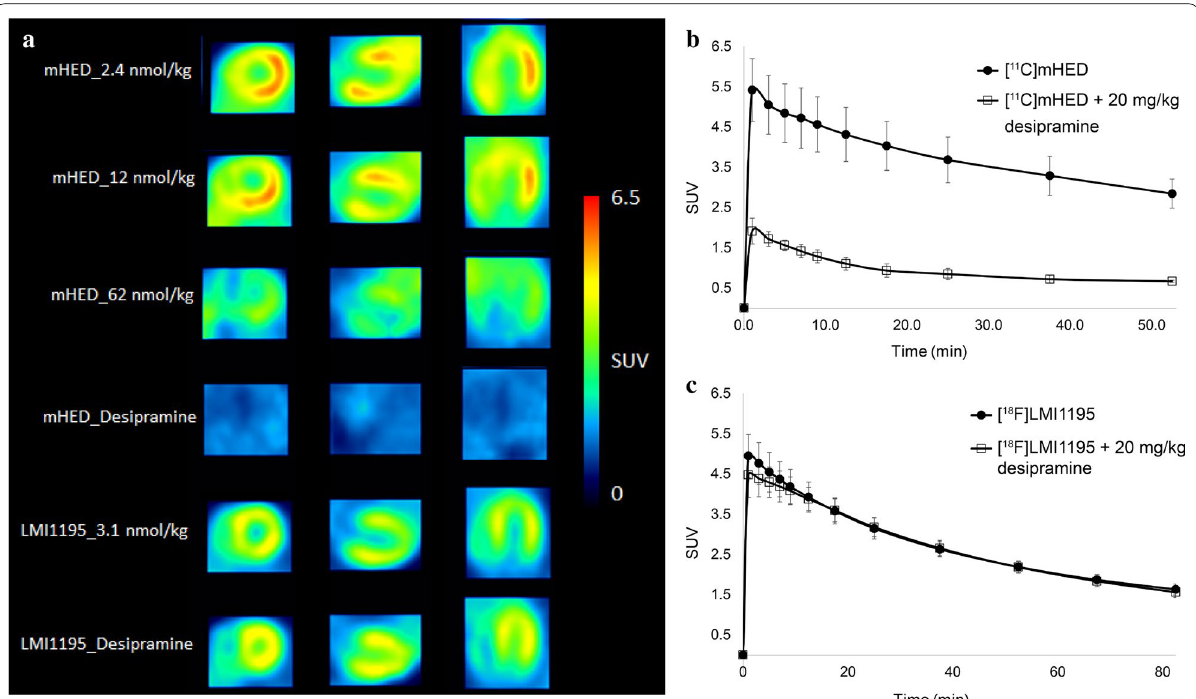
Fig. 3 Standard PET images of myocardium after i.v. injection of [ 11 C]mHED or [ 18 F]LMI1195 in FVB/N mice. a Representative short-axis (left column), horizontal long-axis (middle column), and vertical long-axis (right column) PET images at various extents of NET saturation with metaraminol (mHED with indication of total mass of [ 11 C]mHED and metaraminol) or desipramine (20 mg/kg desipramine HCl as indicated) and [ 18 F]LMI1195 under baseline conditions or with desipramine. SUV was averaged from 1 to 31 min p.i. b TACs after injection of [ 11 C]mHED alone (9.2–16.6 nmol/kg, including metaraminol mass; n 3) and [ 11 C]mHED (9.6–10.5 nmol/kg) 20 mg/kg desipramine HCl ( n 3). c TACs after injection of [ 18 F]LMI1195 = + = alone (mass range, see Table 1; n 6) and [ 18 F]LMI1195 (mass range, see Table 1) 20 mg/kg desipramine HCl ( n 6). Mean values with = + =